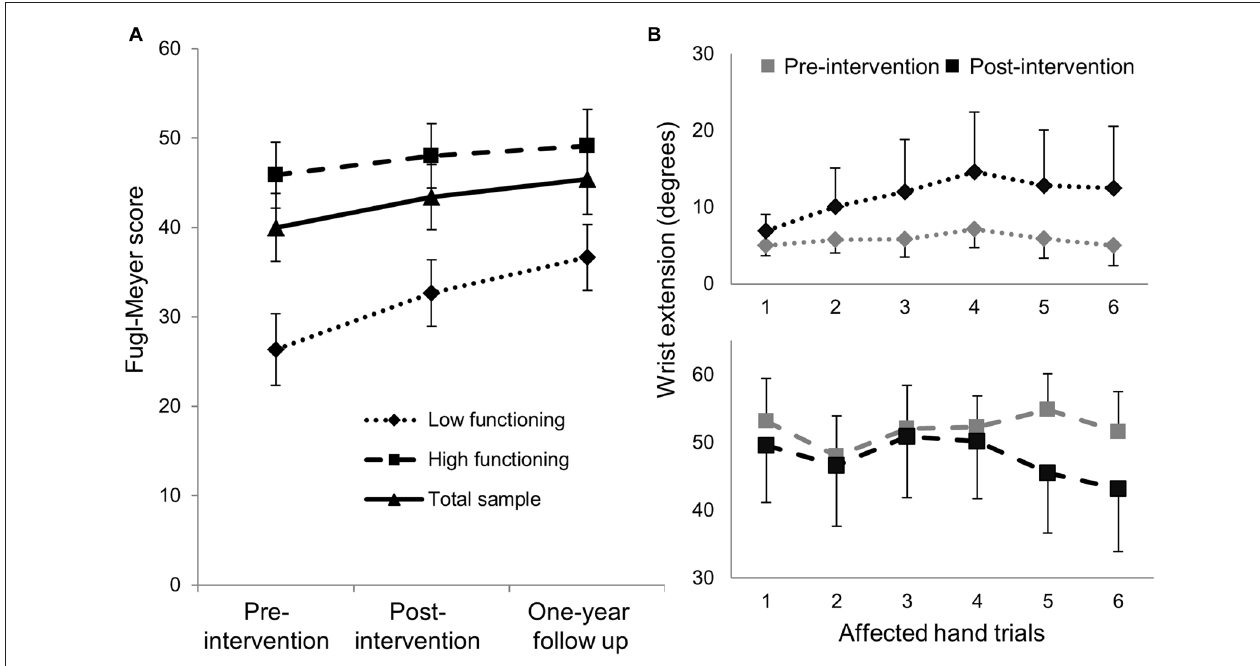
FIGURE 2 | (A) Mean ( ± SE) Fugl-Meyer scores in low-functioning subjects ( n = 5) showed greater improvement compared with high-functioning subjects ( n = 8). (B) The low-functioning subjects (active wrist range-of-motion < 15 ◦ ) showed better bimanual-to-unimanual learning across trials with the affected hand post-intervention than the high-functioning subjects (active wrist range-of-motion > 30 ◦ ).